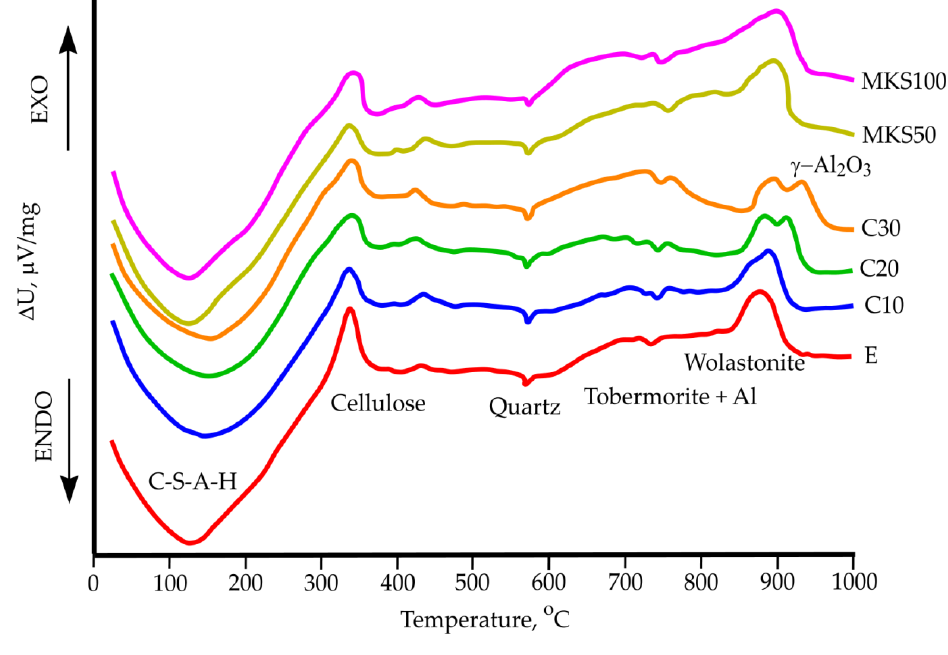
Figure 11. Sample DTG results.